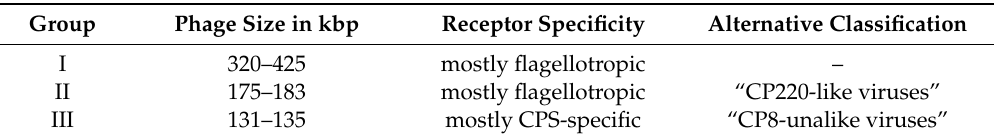
Table 1. Classification of lytic Campylobacter